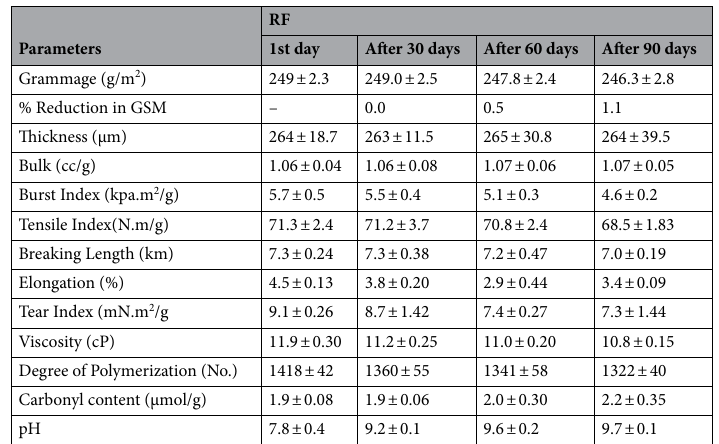
Table 1. mechanical properties of unbleached pulp sheets of controlled sample.